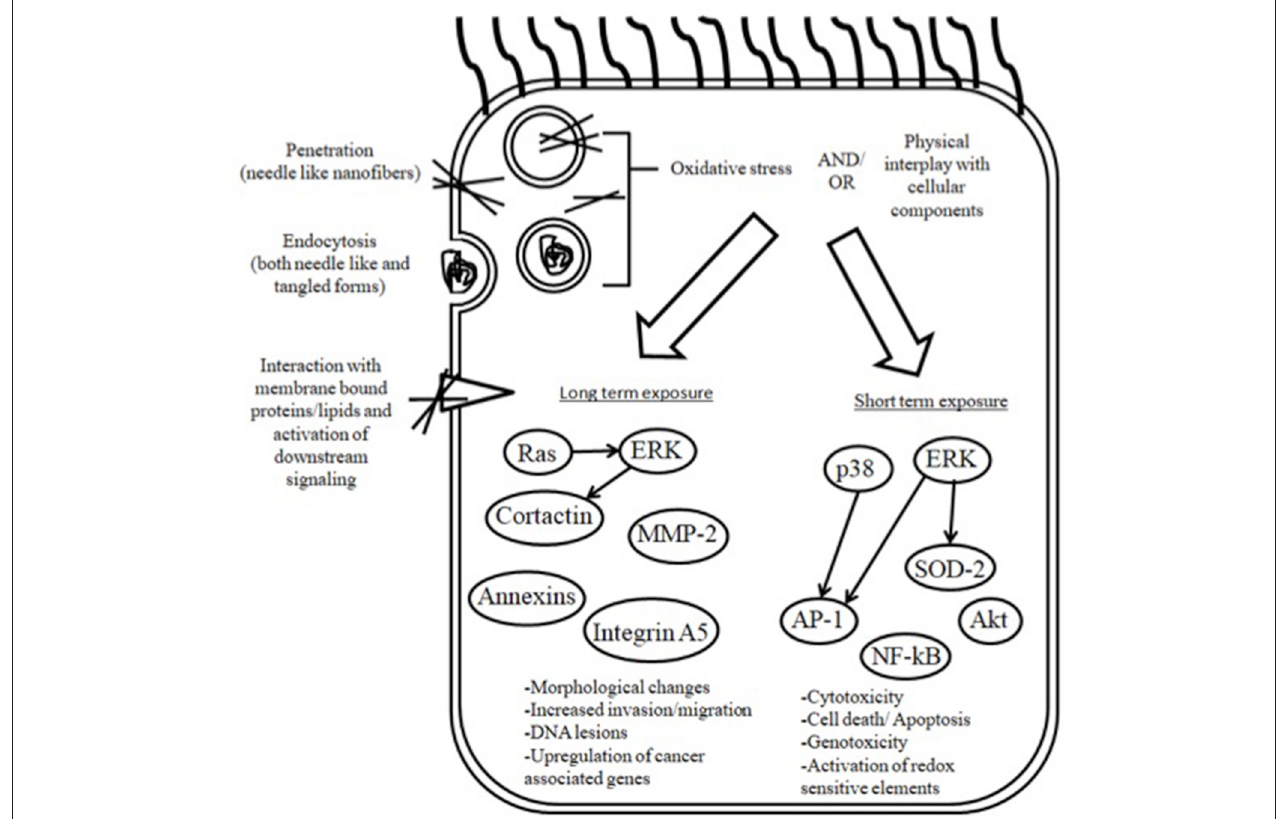
FIGURE 1 | Overview of the mechanisms of cellular uptake and toxicity of CNTs in mesothelial